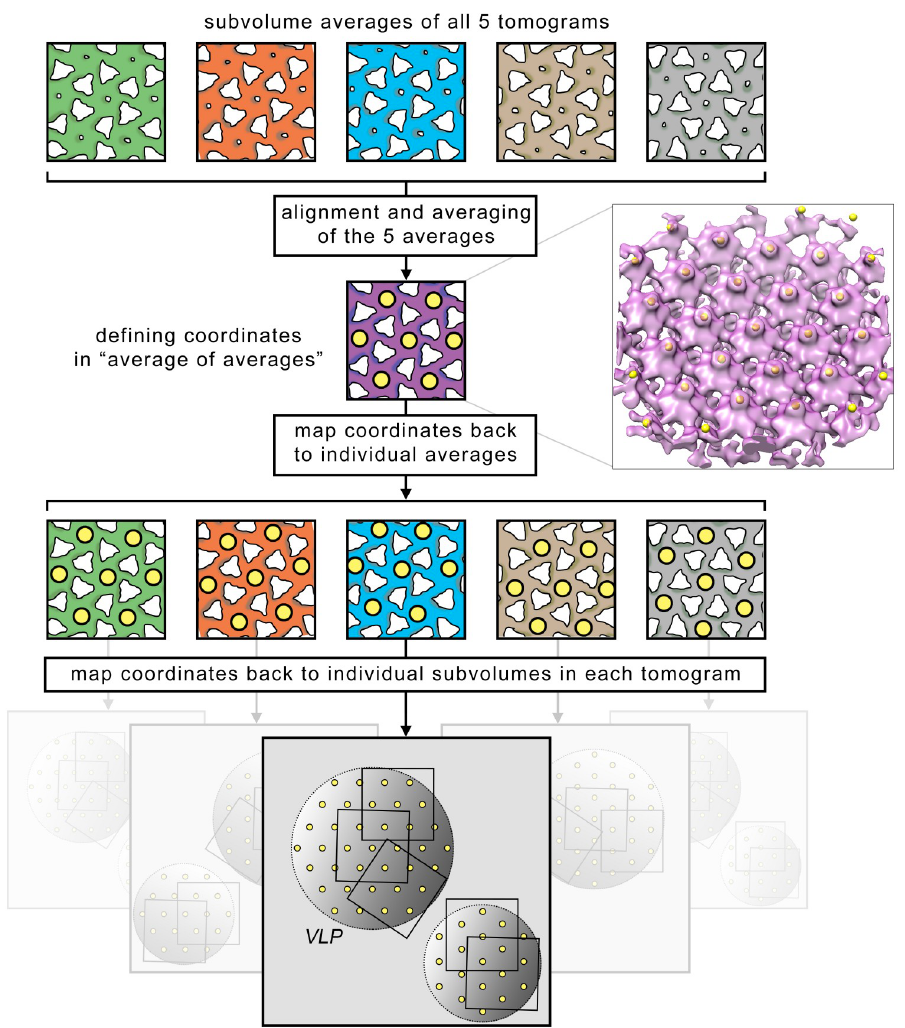
Fig 5. Illustration of 2-step subboxing for particle picking. After the tomogram averages have been aligned and the “average of averages” has been computed, the coordinates (yellow dots) of all unit cells are manually marked in the “average of averages.” The coordinates are then first mapped onto the tomogram averages, and, finally, onto the corresponding tomograms themselves, resulting in a coordinate grid with the expected hexameric geometry fully covering the surface of the VLPs. On the right of the illustrated “average of averages,” all marked centers of the unit cells on the actual “average of averages” produced with this protocol are shown. The coordinates were marked in Chimera UCSF using the volume tracer tool. With this procedure, candidate coordinates of all unit cells can be determined for the full dataset by manually labeling only 1 single density map. VLP, virus-like particle.